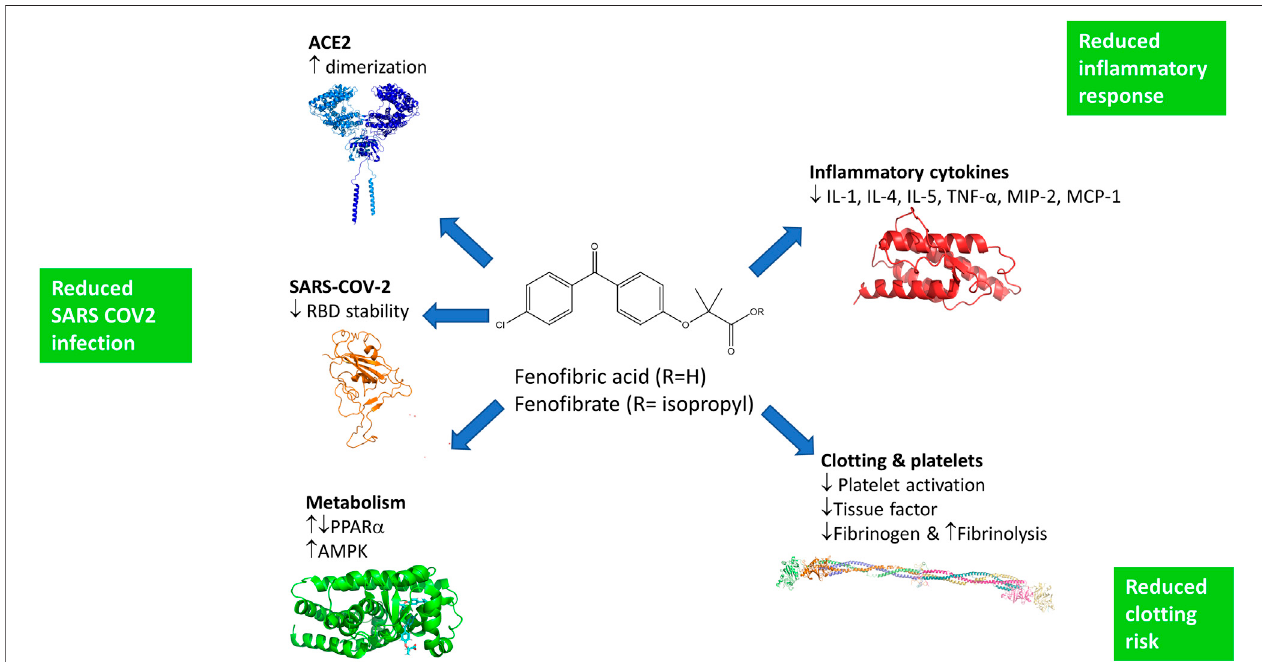
FIGURE 6 | Potential mechanisms by which feno fi brate may improve the treatment of SARS-COV-2 infections. Feno fi bric acid, the metabolite of feno fi brate, stimulates ACE2 dimerization, destabilizes the RBD, and exerts metabolic effects which are likely to reduce infection. Feno fi bric acid possesses anti-in fl ammatory properties which are likely to blunt the immune response and correspondingly alleviate symptoms. Lastly, feno fi bric acid inhibits platelet activation and aggregation, which is anticipated to reduce the hemodynamic problems seen in SARS-COV2